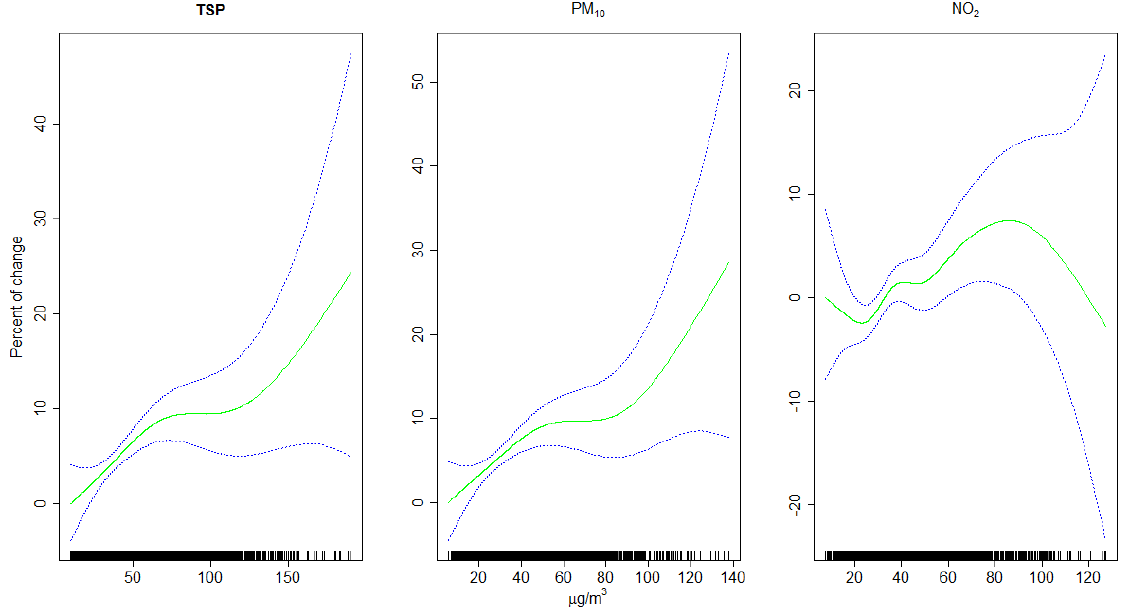
Figure 3. Per cent change in daily mortality, with 95% confidence intervals, in Graz (1990–2005), related to pollutants’ concentration over the same and the preceding day (lag 0–1). Degrees of freedom: 3.1 (TSP), 3.3 (PM10), 5.4 (NO